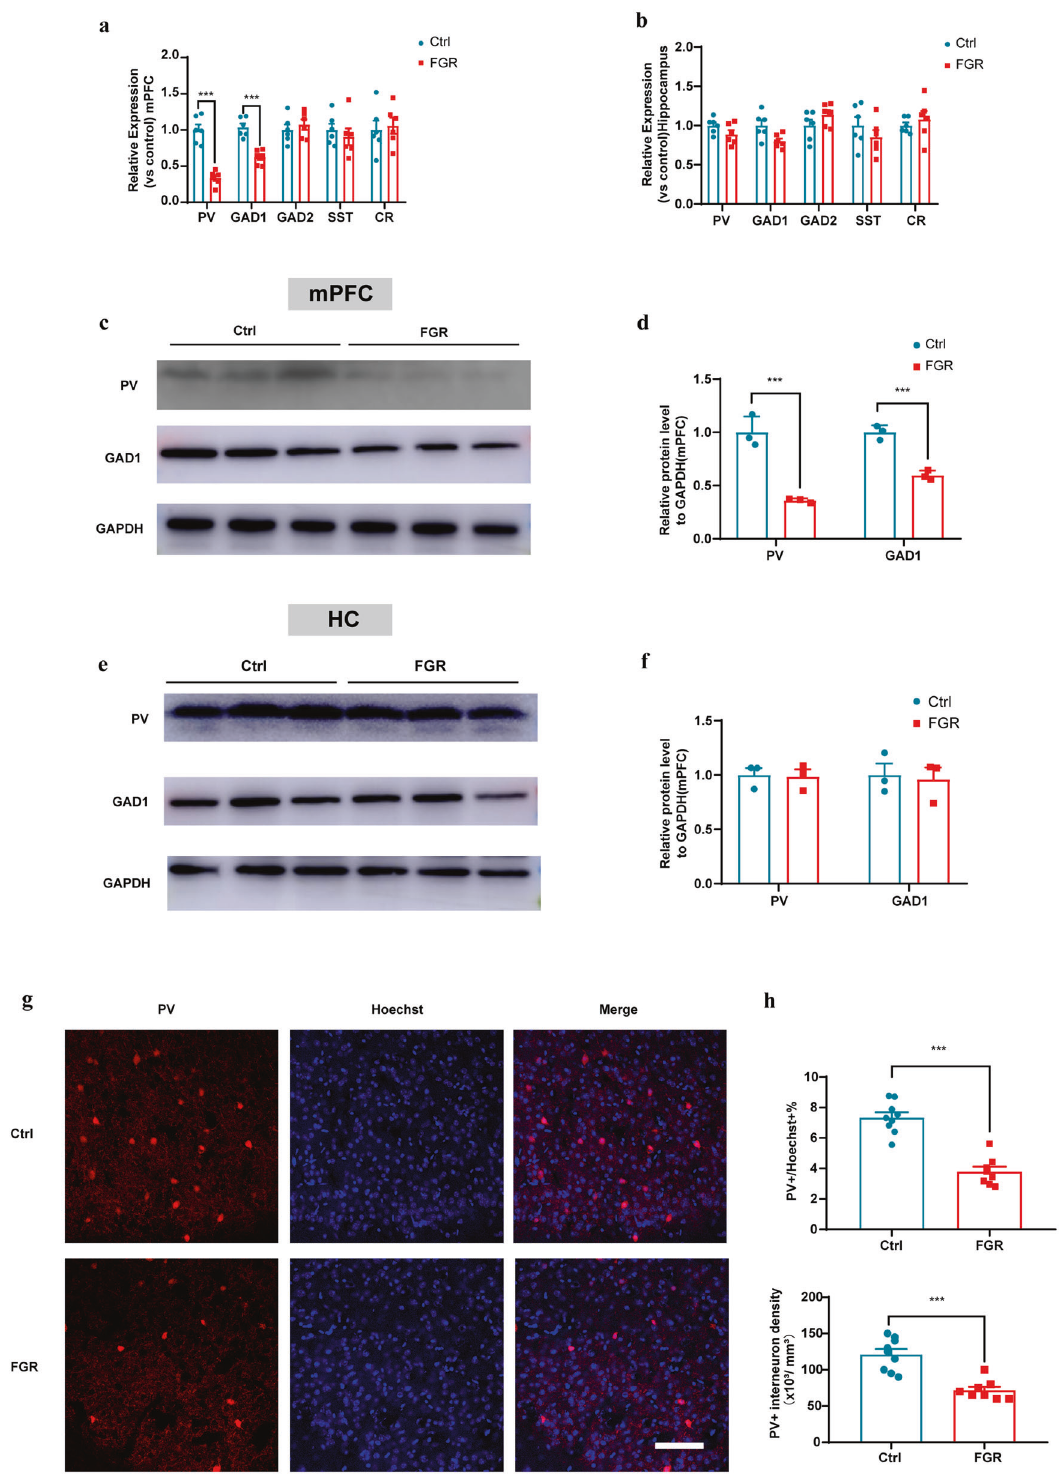
Fig. 2 FGR results in mPFC PV interneuron GABAergic maturation defects. a PV, GAD1, GAD2, SST and CR mRNA levels in the mPFC of control ( n = 6) and FGR ( n = 6) mice. PV: unpaired t test, P < 0.001. GAD1: unpaired t test, P < 0.001. GAD2: unpaired t test, P = 0.496. SST: unpaired t test, P = 0.529. CR: unpaired t test, P < 0.001. b PV, GAD1, GAD2, SST, and CR mRNA levels in the hippocampus of control ( n = 6) and FGR ( n = 6) mice. PV: unpaired t test, P = 0.054. GAD1: unpaired t test, P = 0.159. GAD2: unpaired t test, P = 0.166. SST: unpaired t test, P = 0.313. CR: unpaired t test, P = 0.491. c , d Representative blots and statistical analysis of PV and GAD1 protein in the mPFC. e , f Representative blots and statistical analysis of PV and GAD1 protein in the hippocampus. g Representative images of mouse mPFC region immunostained with PV and Hoechst antibodies. Scale bar = 100 μ m. h Statistical analysis of PV interneuron percentage and density in mPFC region, n = 9 in control group, n = 8 in FGR group. The results are expressed as mean ± SD.; * P < 0.05, ** P < 0.01 and *** P < 0.001.